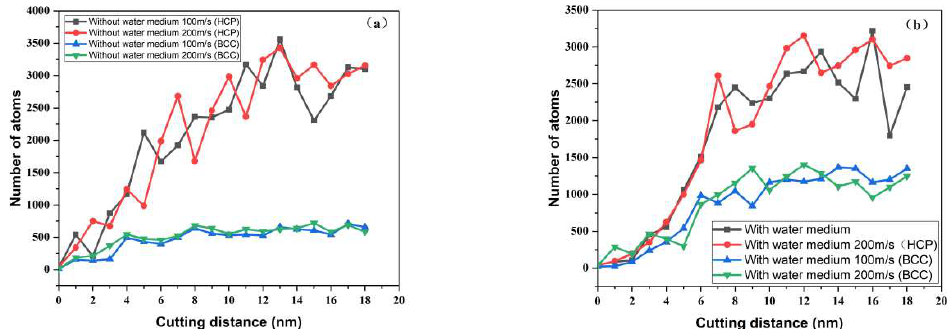
Figure 15. Crystal structure transition curves at different cutting speeds (( a ) without water medium ( b ) with water medium).